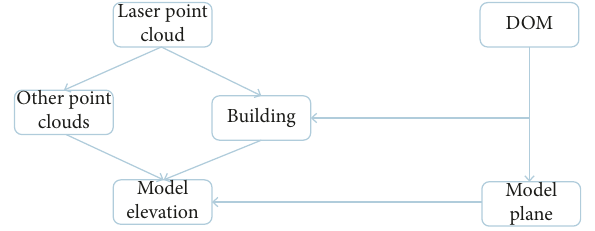
Figure 2: Modeling